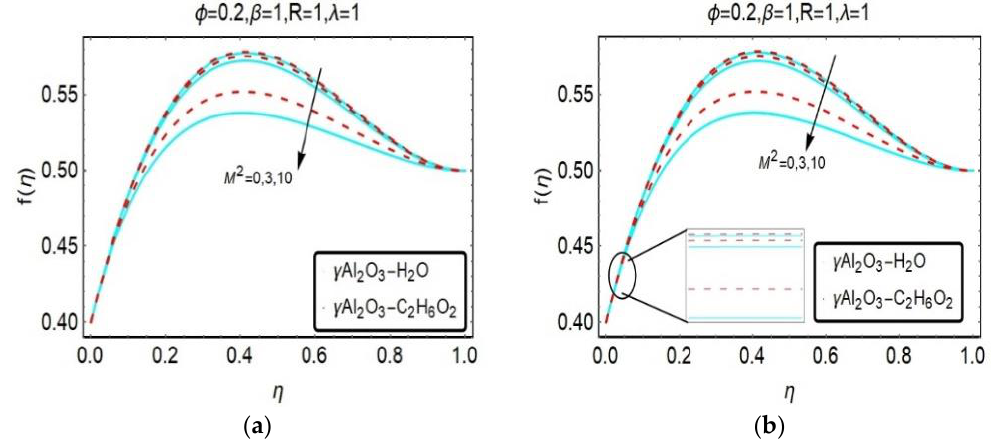
( b ) Figure 2. Influence of 𝑅 on 𝑓(𝜂) for ( a ) 𝑆 > 0 and ( b ) 𝑆 < 0 .